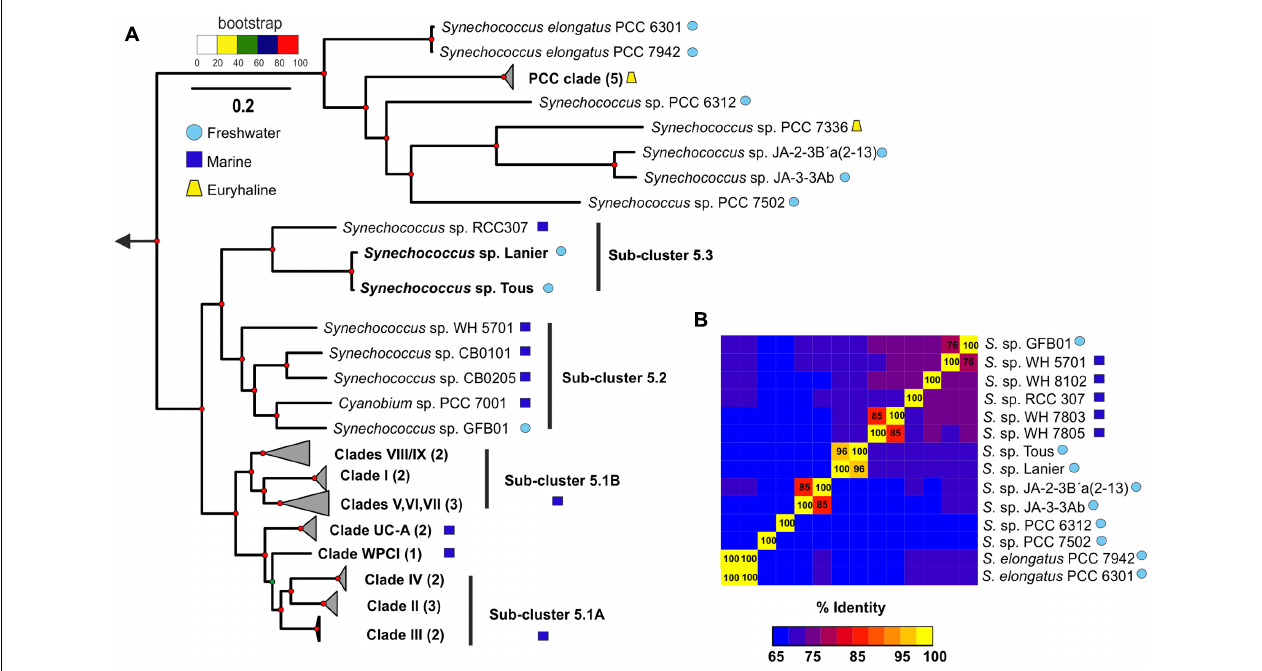
FIGURE 1 | (A) Phylogenomics of the genus Synechococcus sp. One hundred twenty-two conserved genes were used to generate a maximum-likelihood phylogenetic tree with marine, freshwater and the novel Synechococcus sp. representatives. Three Prochlorococcus genomes were used as an outgroup. (B) ANI (average nucleotide identity) between the closest marine and freshwater representatives to the novel Synechococcus sp. Tous/Lanier.